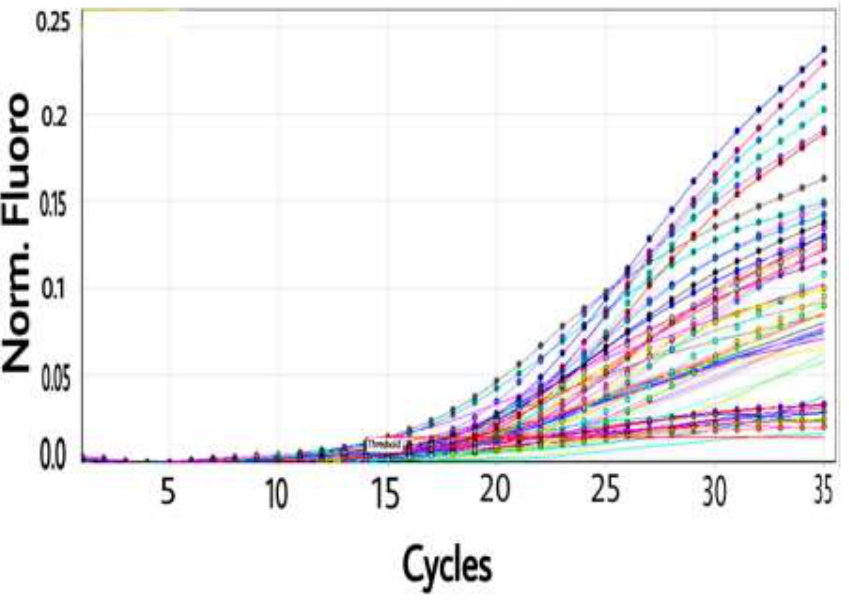
Figure 2: Allelic Discrimination Report generated by Rotor-Gene Q Series Software 2.1.0 (Cycling A. Green= No Markers, Cycling A. Yellow= Circles), show that sample with mutant genotype have a high reaction (samples color blue, black, red) followed by samples with heterozygous genotype (orange, green, pink) and samples with wild type genotype (purple, gray) have the lowest